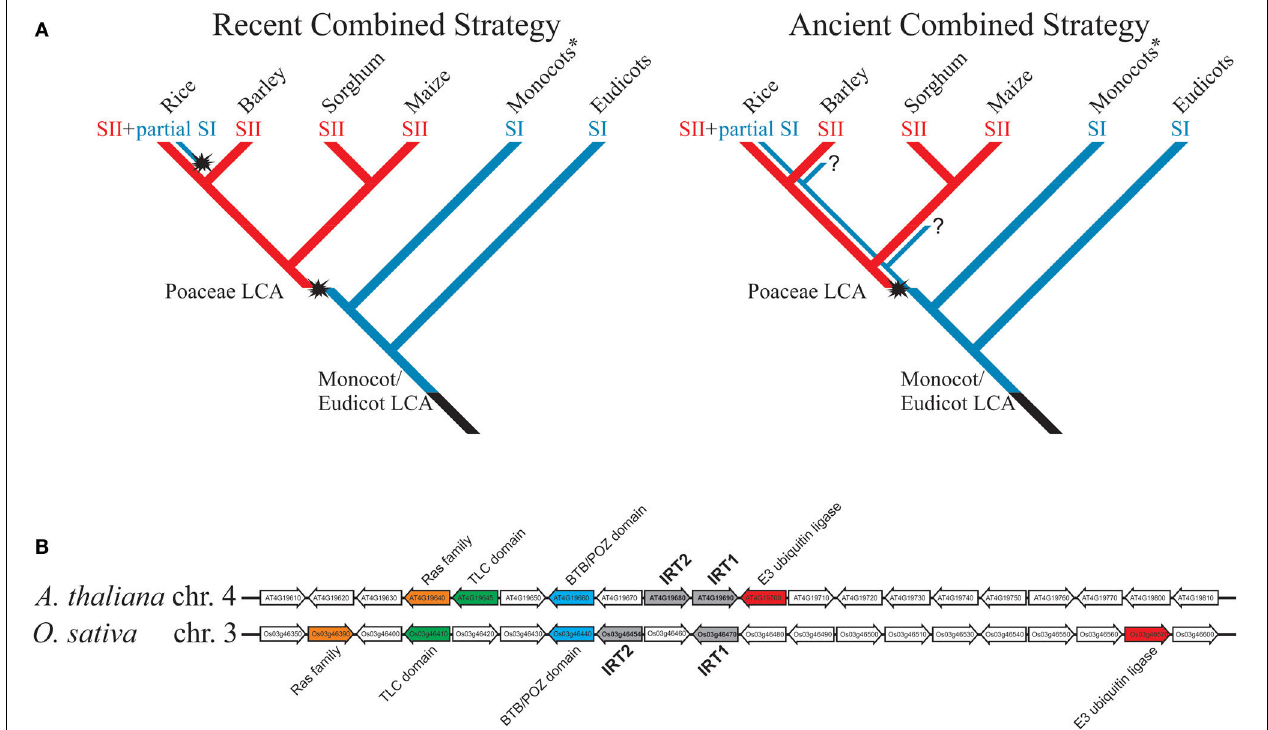
FIGURE 1 | (A) Models for evolution of rice combined strategy for Fe uptake. Blue lines represent plants using strategy I for Fe uptake; red lines represent plants using strategy II. Evolutionary novelties are highlighted, as the appearance of strategy II in Poaceae group and the putative re-appearance of IRT1-mediated Fe 2 + uptake in rice, also known as the combined strategy (strategy II + partial strategy I). Question marks denote unclear points. Monocots* are all non-Poaceae monocotyledonous plants. SI = strategy I; SII = strategy II; LCA = last common ancestor.